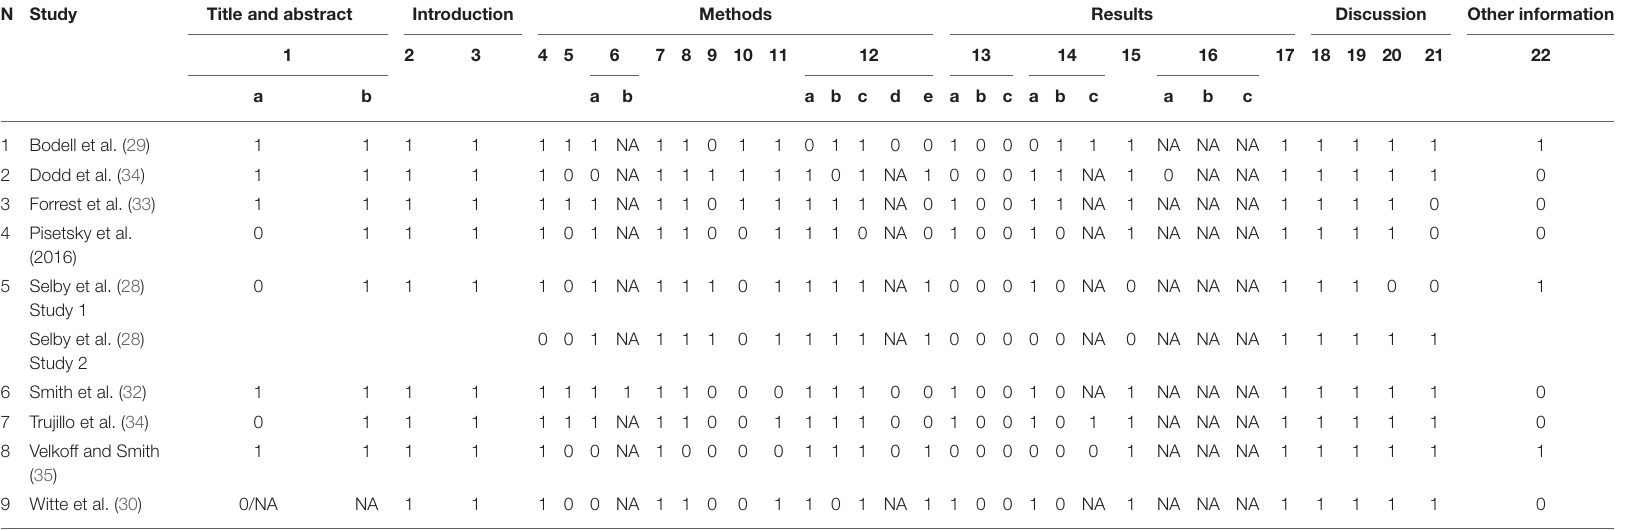
TABLE 2 | Strengthening the Reporting of Observational Studies in Epidemiology (STROBE) scores of the included studies.